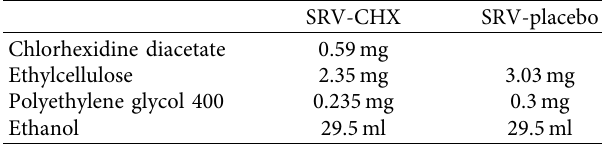
Figure 1: Dental abutments before and after coating with SRV-CHX. Upper panel: three kinds of sterile dental abutments: GM PEAK healing abutment 5.5 × 2.5 mm [1] (a), GM titanium healing abutment 3.3 × 2.5 mm [2] (b), and GM titanium permanent abutment 4.5 × 6 × 2.5mm [3] (c) were used for this study. Lower panel: the lower screw part of abutments 1, 2, and 3 were coated with the SRV-CHX ((d)–(f), respectively), and allowed to dry aseptically at room temperature. Table 1: The wet formula of SRV-CHX and SRV-placebo.